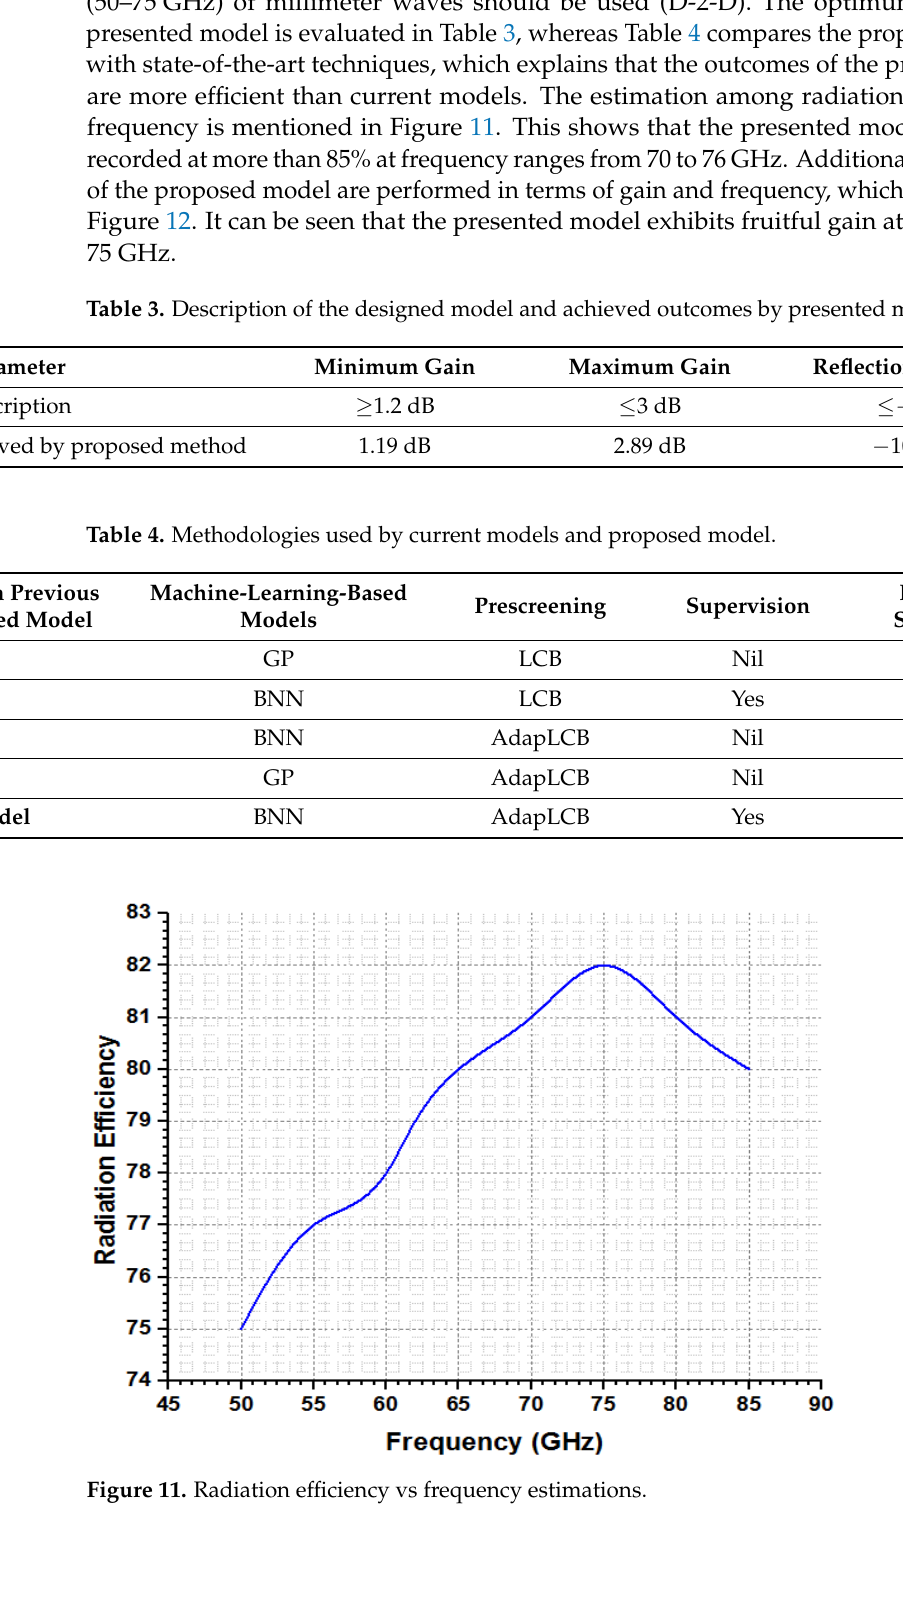
Figure 12. Investigation of gain as function of frequency. Table 3. Description of the designed model and achieved outcomes by presented model. Parameter